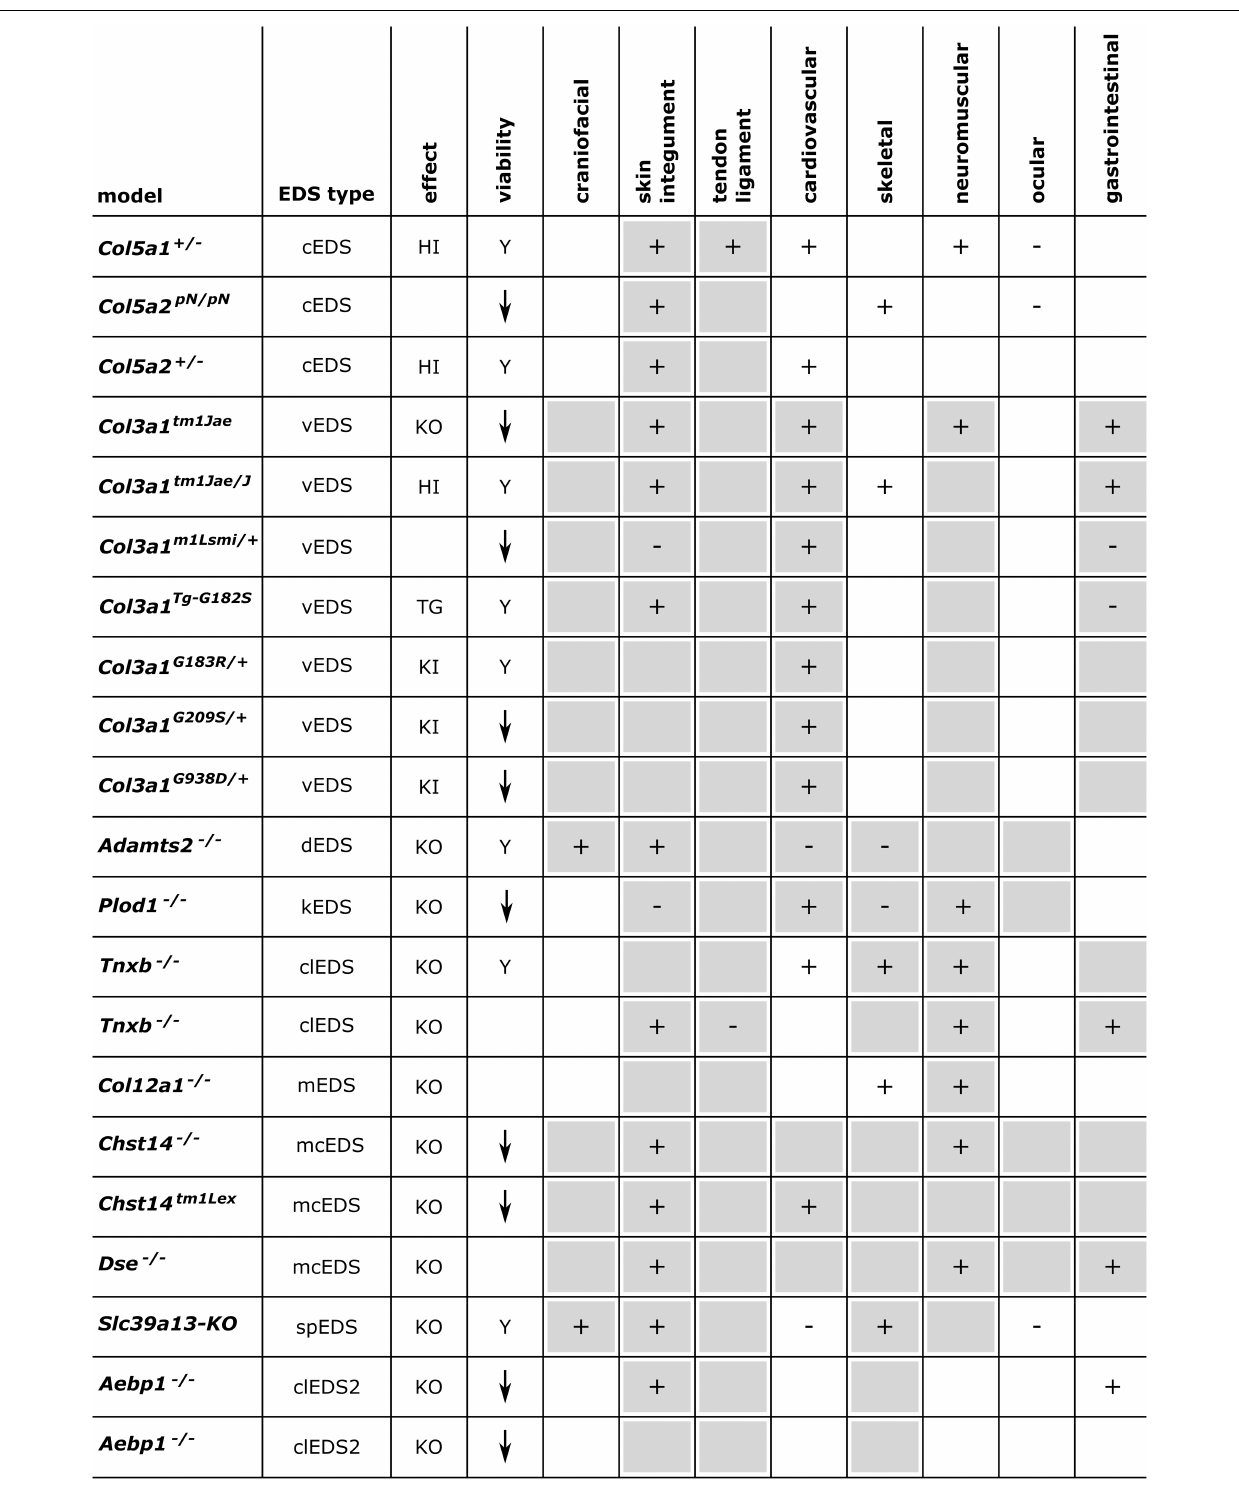
Frontiers in Genetics |